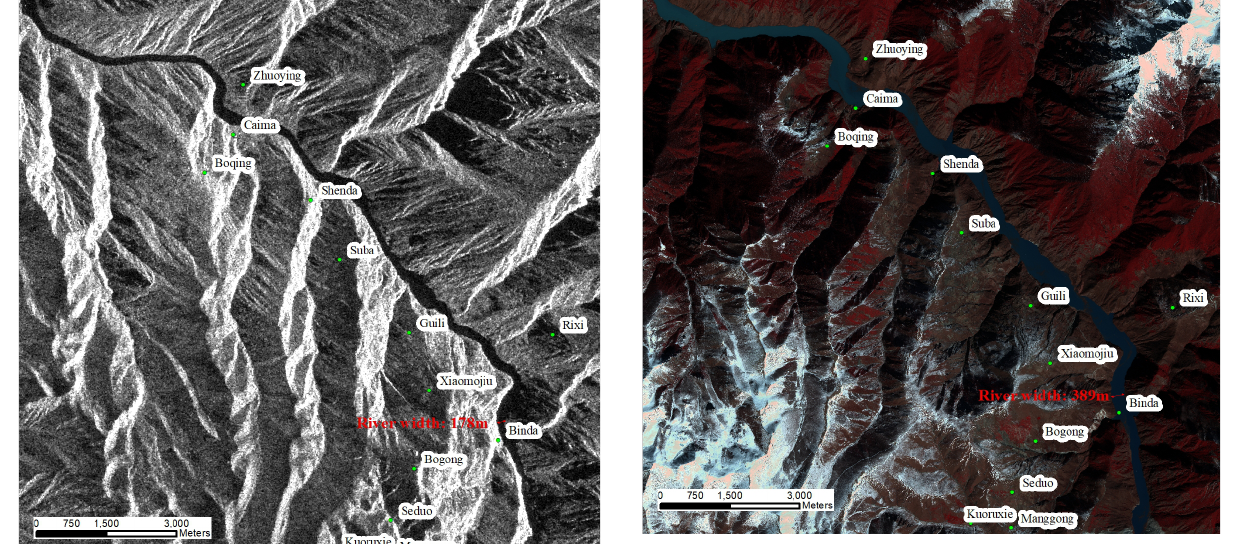
Figure 8. False colour composite BJ-2 image on Nov 9, 2018